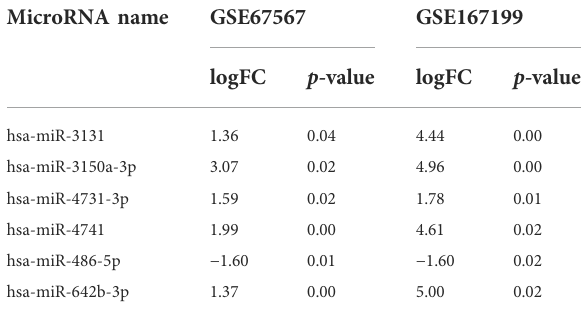
TABLE 1 Signi fi cantly differentially expressed miRNAs in both